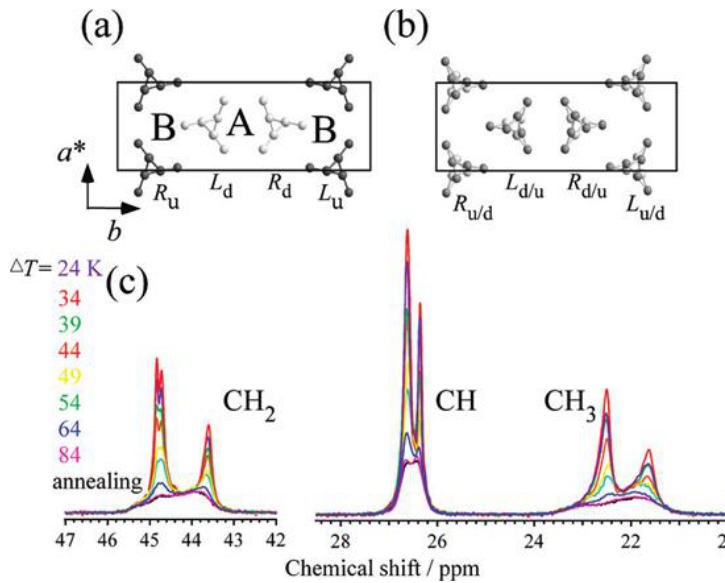
Figure 10. Unit-cell structures of ( a ) α 2 and ( b ) α 1 forms of i PP. ( c ) The 13 C CPMAS NMR spectra for the pure α form of i PP at different supercoolings. (Reprinted with permission from J. Phys. Chem. B 2010 , 114 , 92 – 100. Copyright (2010) American Chemical Society).